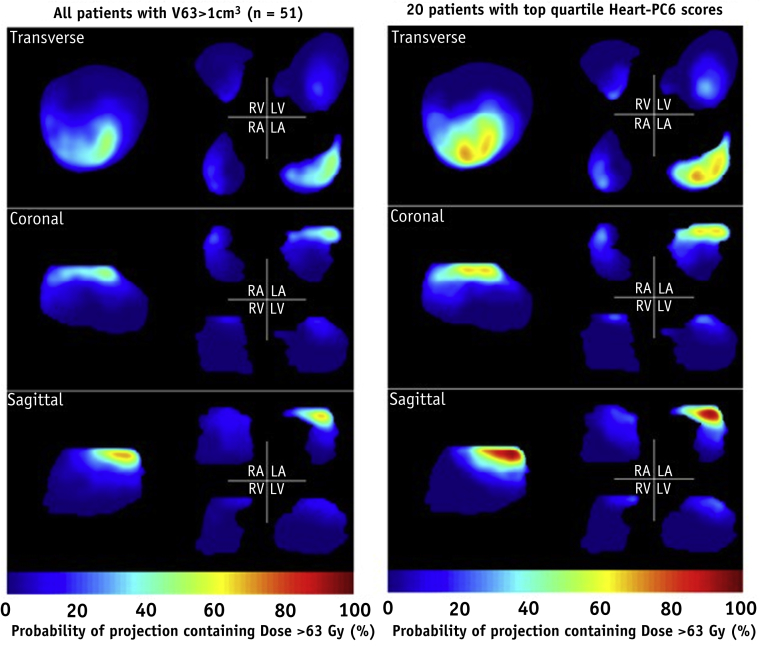
Three perspective views of the reference whole-heart geometry, and the left/right atria (LA/RA) and ventricles (LV/RV) plotted separately. The colorwash indicates percentages of patients whose heart dose distributions, mapped to the reference geometry, have values ≥63 Gy somewhere along lines perpendicular to the image plane. Data are shown for the 51 patients with VHeart63>1 cm3 (left) and the 20 patients with the highest Heart-PC6 scores (right).